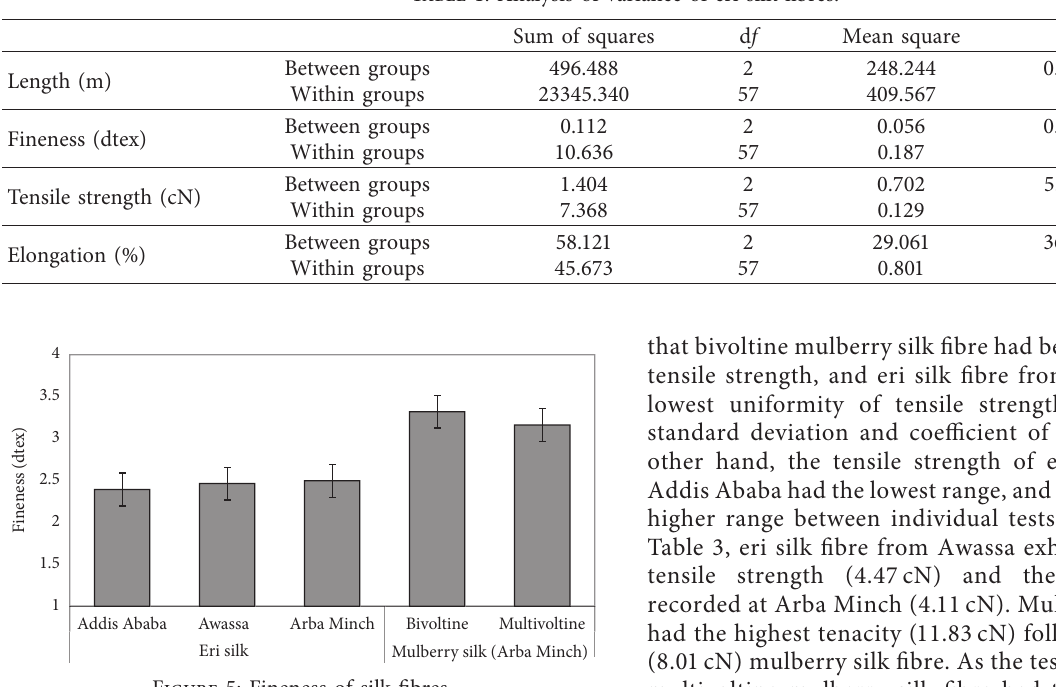
Table 1: Analysis of variance of eri silk fibres.